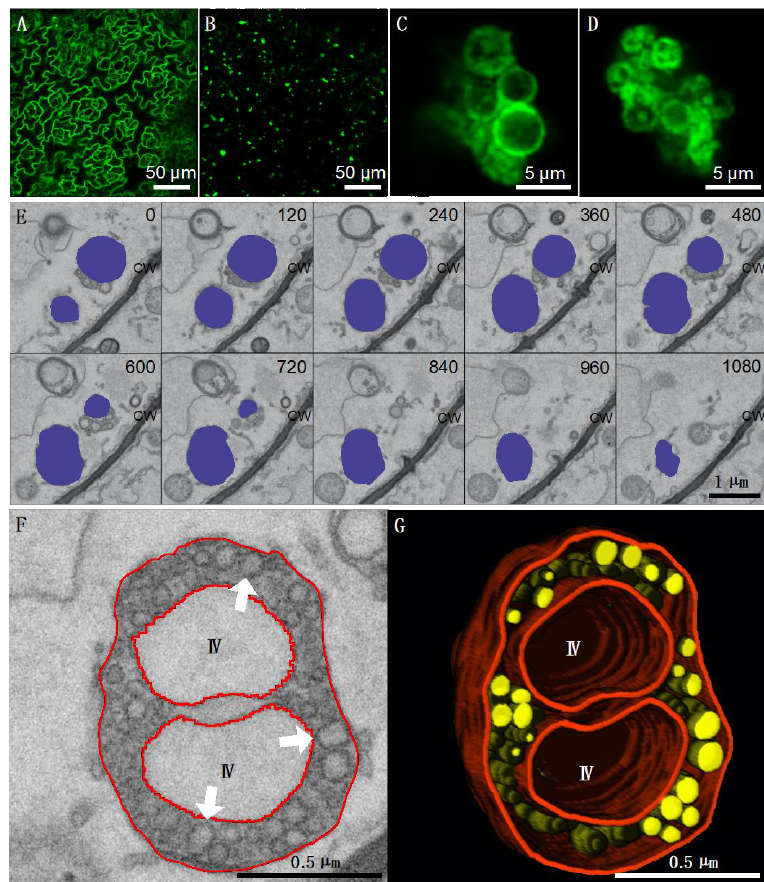
Figure 2. TBSV replicates in association with peroxisomes in Arabidopsis thaliana . Confocal microscopy imaging of leaf epidermal cells from healthy ( A ) and TBSV-infected ( B – D ) 35S:B2:GFP A. thaliana Col-0